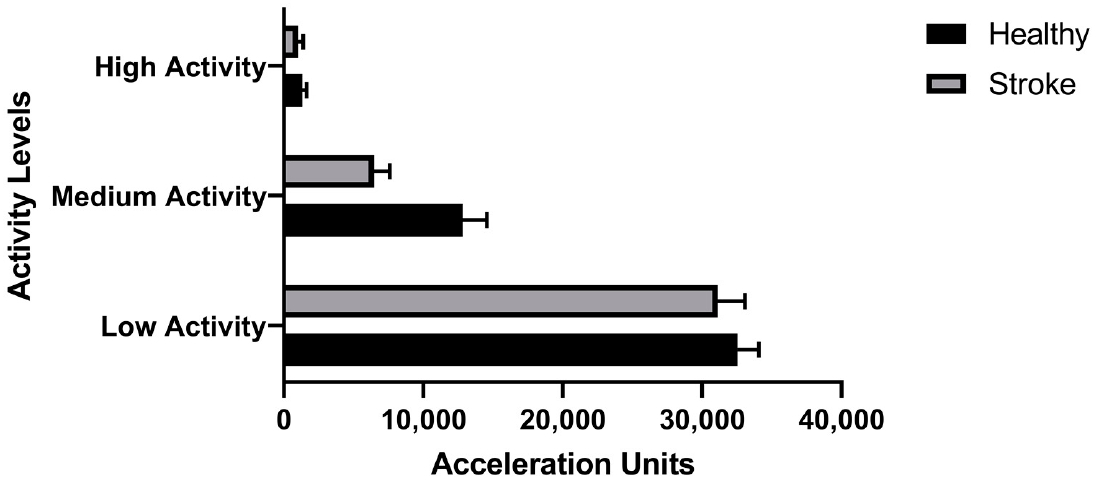
Figure 8. Total activity amplitudes (AAs) with low, medium, and high amplitudes among stroke and healthy adults.